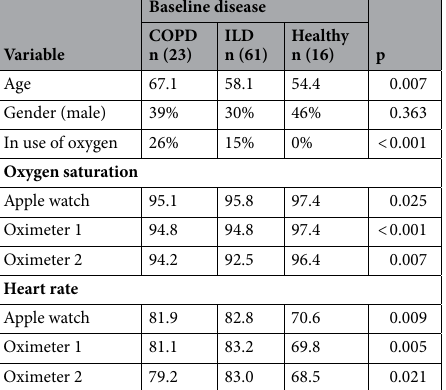
Table 1. Subject demographics. ILD Interstitial lung disease, COPD chronic obstructive pulmonary disease.